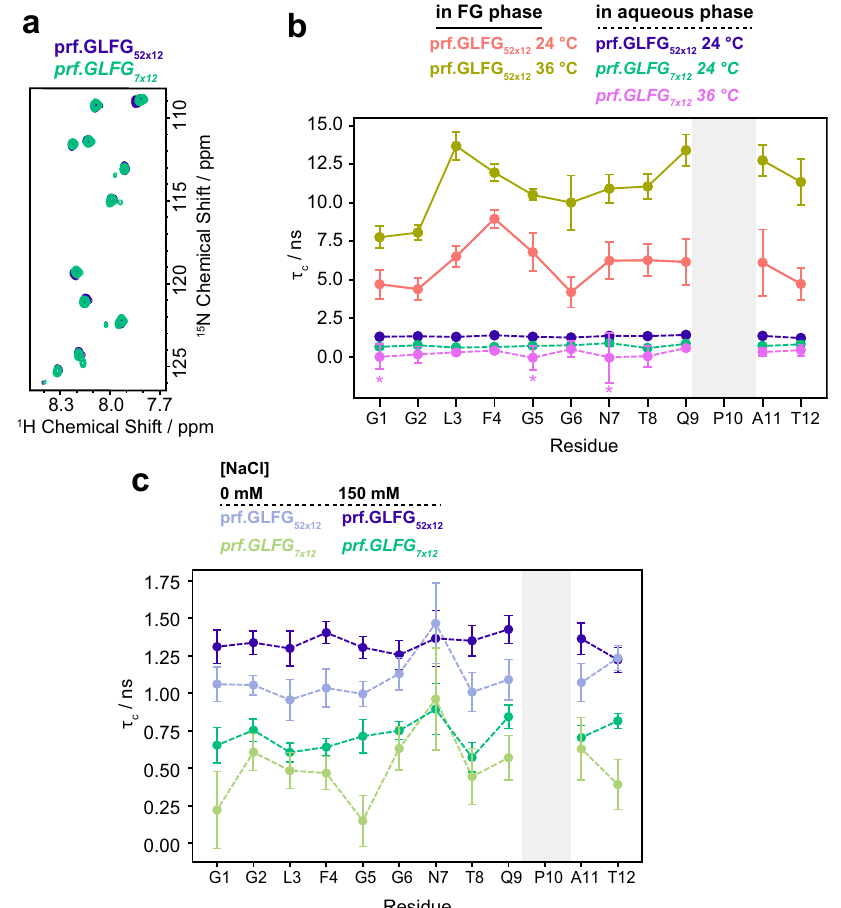
Fig. 4 Effect of temperature, phase separation and salt on the residue-speci fi c dynamics of prf.GLFG 52×12 . a 15 N- 1 H HSQC spectra of the prf.GLFG 7×12 peptide (green) and the full-length prf.GLFG 52×12 protein (blue) in solution at 24 °C. b Residue-speci fi c rotational correlation times ( τ c ) as determined by [ 15 N, 1 H]-TRACT 79 for prf.GLFG 52×12 in either FG phase or aqueous phase, and prf.GLFG 7×12 at different temperatures in a 20 mM sodium phosphate buffer at pH 6.8 containing 150 mM NaCl. Rotational correlation times are plotted as calculated from the best fi t values of R α and R β from a single measurement. Error bars are shown as ±standard deviations (S.D.s). S.D.s were obtained from the exponential fi ts of the transverse relaxation rates R α and R N = 10000) was then used to estimate the S.D.s of rotational correlation times. The pro fi le of the full-length β , and the Monte Carlo method ( prf.GLFG 52×12 at 36 °C (yellow-brown), and at 24 °C (peach) in the FG phase is shown with solid lines. Dashed lines indicate measurements in solution: full-length prf.GLFG 52×12 in soluble state at 24 °C (blue), prf.GLFG 7×12 at 24 °C (green), and prf.GLFG 7×12 at 36 °C (pink). The dynamics of the full-length construct could not be determined in solution at 36 °C due to its extremely low critical concentration. At 36 °C, the exact correlation times of G1, G5, and N7 in the prf.GLFG 7 ×12 peptide could not be determined, as the relaxation rates of α and β states of the amide 15 N are similar within the range of errors. The τ c -values of these three residues are marked with an * and plotted as 0. c Aqueous phase full-length prf.GLFG 52×12 and prf.GLFG 7×12 in 20 mM sodium phosphate buffers at pH 6.8 containing either 0 mM or 150 mM NaCl and measured by TRACT at 24